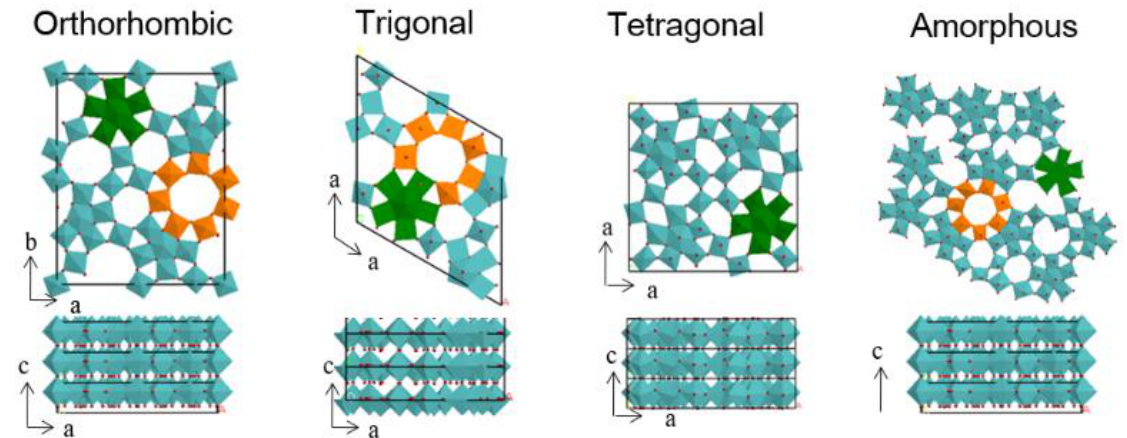
Figure 3. Structures of Mo 3 VO x catalysts employed in the selective oxidation of allyl alcohol to acrylic acid.